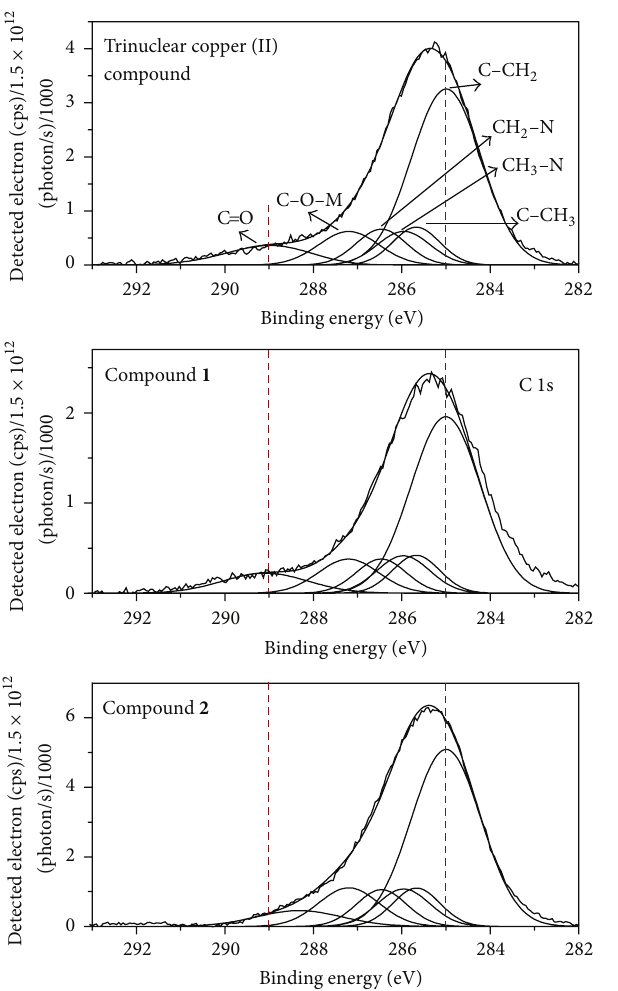
Figure 10: XPS spectra O1s core level for [Cu 3 ( S,S (+)cpse) 3 (H 2 O) 3 ] ⋅ 8H 2 O and compounds 1 and 2 .